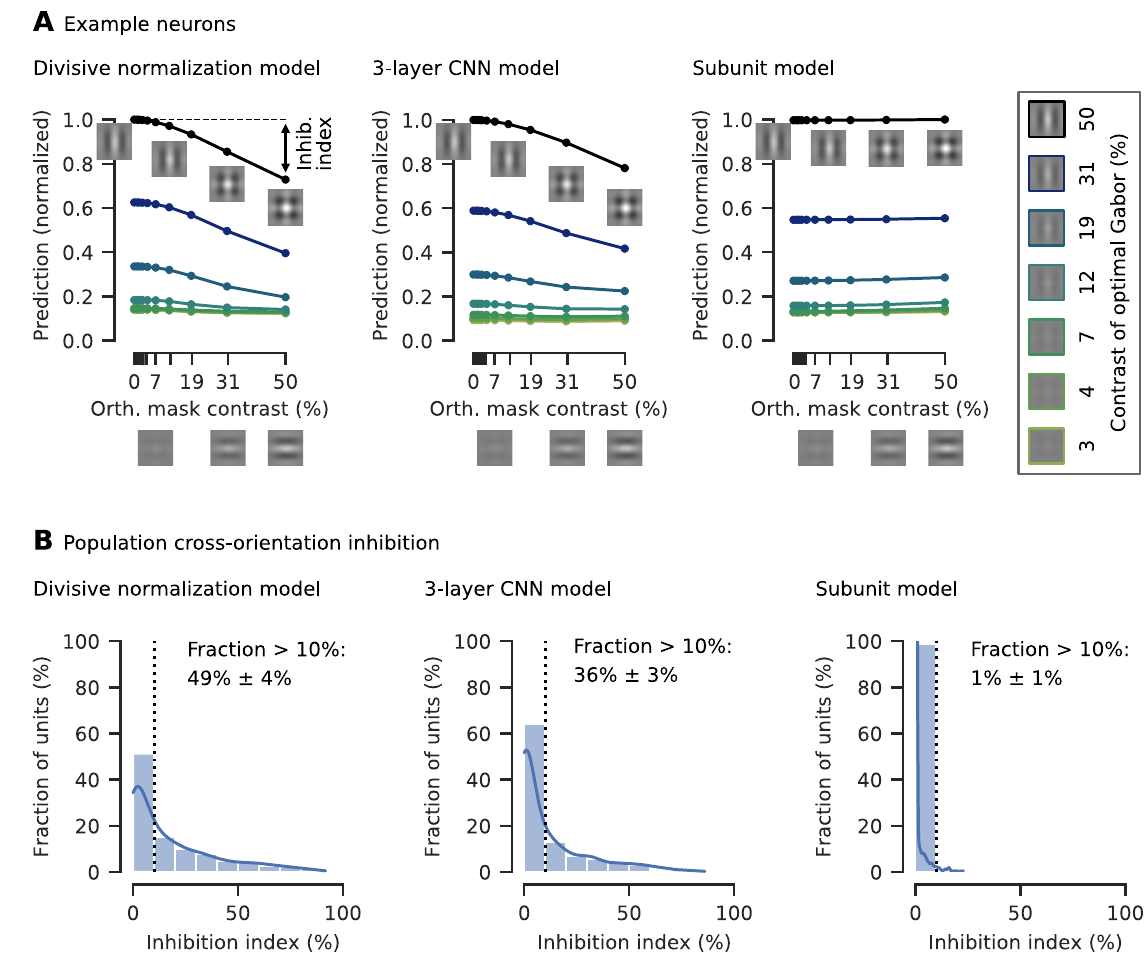
Fig 4. Cross-orientation inhibition was learned by our DN model and the three-layer CNN, but not significantly by the subunit model. A . Tuning curves for an example neuron of all three models and various contrast combinations of the optimal Gabor (box on the right, examples for contrasts of 0%, 1% and 2% not shown) and an orthogonal Gabor masking. As the contrast of the orthogonal mask increases, the model prediction (normalized by the maximum response) decreases. The cross-orientation inhibition (inhib.) index measures the percentage of response inhibition by adding the masking compared to the optimal Gabor presented alone, in this case approximately 20%. A . insets : Illustration of plaid stimuli, created by overlaying an optimally oriented Gabor with an orthogonal mask. B . Histograms of the cross-orientation inhibition indices accumulated across the best ten models (in terms of validation set accuracy) per model type, with kernel density estimate of the underlying distribution. The fraction of cells that show more than 10% cross-orientation inhibition is displayed right of the dotted line (mean and 95% confidence interval over the ten best models selected in terms of validation set accuracy). For the DN model, more cells show cross-orientation inhibition compared to the other models. The subunit model shows almost no cross-orientation